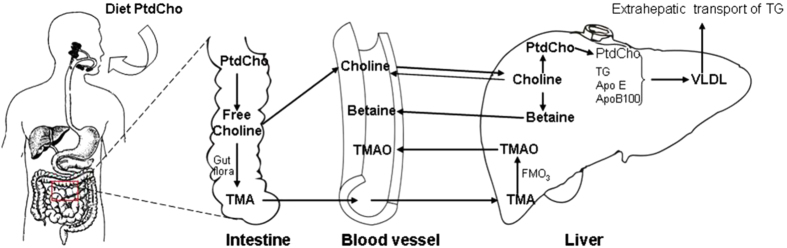
Schematic chart of choline metabolism.The chart was drawn by Y.L. and H.L.Z. Abbreviations: PtdCho: phosphatidylcholine; TG: Triglyceride; TMA: Trimethylamine; TMAO: Trimethylamine N-oxide; VLDL: Very low density lipoprotein.